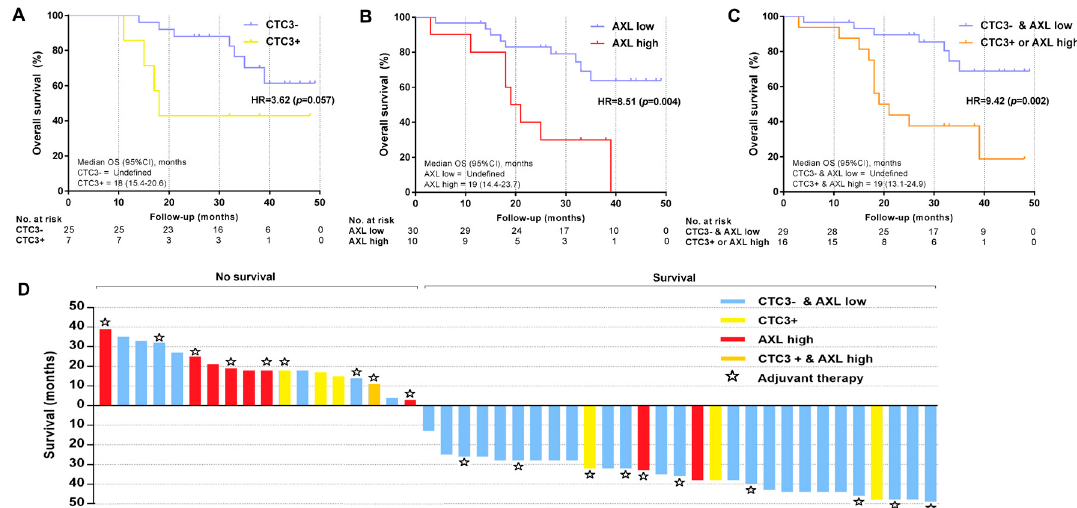
Figure 4. CTCs and tissue AXL as survival prognostic biomarkers in ADC: ( A ): Kaplan–Meier of the Figure 4 influence of CTC3 in the OS. Patients with presence of CTC3 had 3.62 times higher risk of exitus versus those without them. Log-rank (Mantel–Cox) test was applied. ( B ): Kaplan–Meier of the influence of AXL tissue expression in the OS. Patients with high AXL levels had an 8.51 times higher risk of exitus versus those with low levels. Log-rank (Mantel–Cox) test was applied. ( C ): Kaplan–Meier of the influence of CTC3 and AXL tissue expression in the OS. Patients with high AXL levels or presence of CTC3 had a 9.42 times higher risk of exitus versus patients with low AXL and negative CTC3. Log-rank (Mantel–Cox) test was applied. ( D ): Waterfall plot showing how presence of CTC3 (six months after surgery) (yellow), high AXL tissue expression (red), and both (orange) predicts OS in ADC patients, regardless adjuvant treatment administration